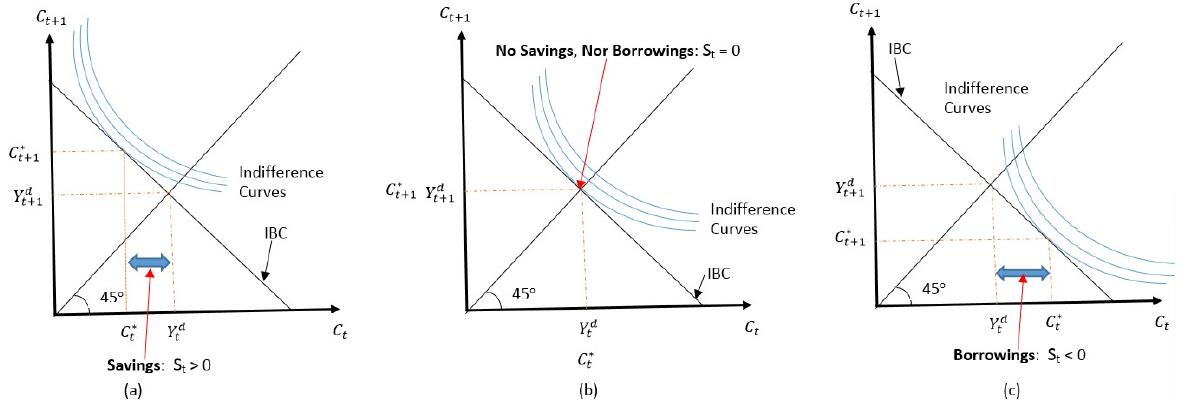
Figure 1. The optimality conditions for consuming, saving, and borrowing in the global economy. Note: In the above graphical representation, the point of tengency between the inter-temporal budget constraint (IBC), and the highest acheivable indifference curve, defines each individual’s optimal first period consumption level, along with the expected second period consumption level, and status as net saver ( a ), or net borrower ( c ), or neither ( b ) in the global entrepreneurial finance market. S t > 0 When an individual has net savings in the